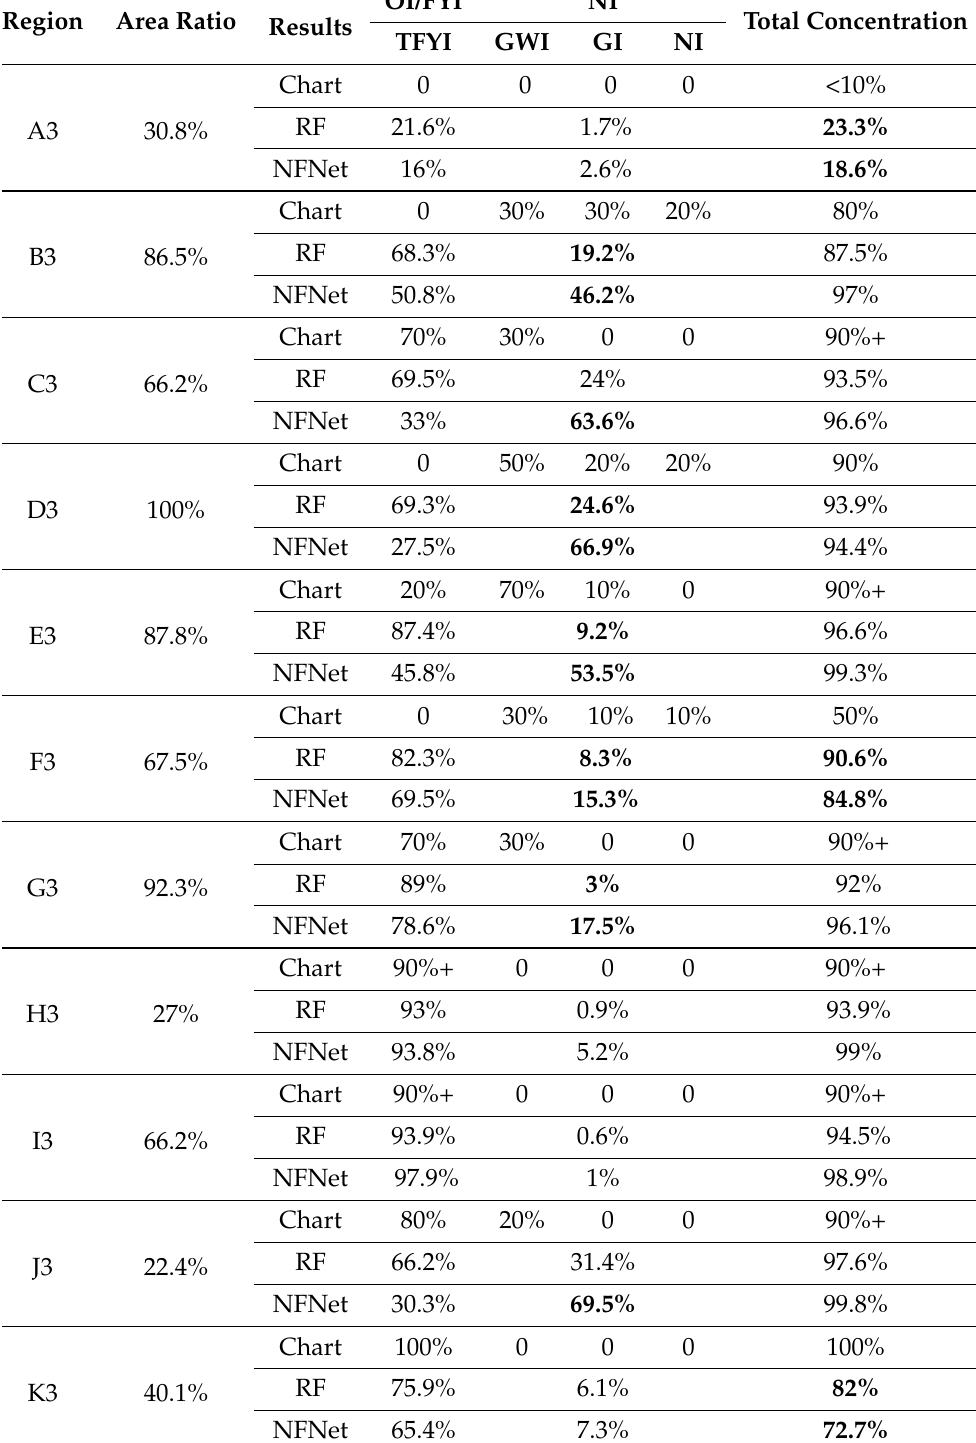
Table 7. Comparison of the estimated concentration for 4